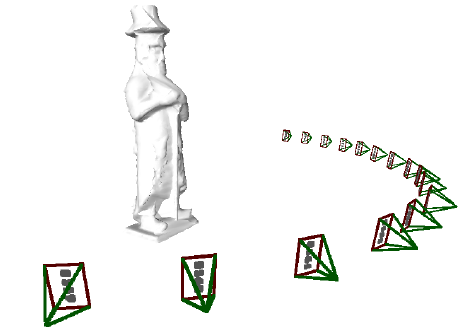
Figure 6: Camera viewpoints after image calibration and orienta- tion were computed.